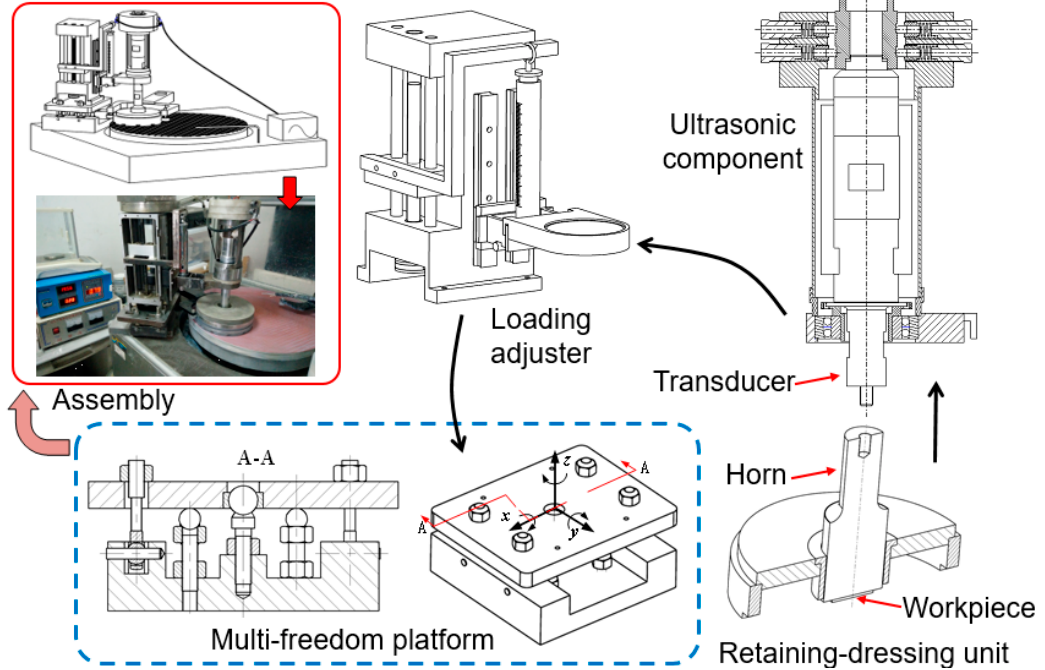
Figure 1. Experimental setup of ultrasonic vibration-assisted composition process.